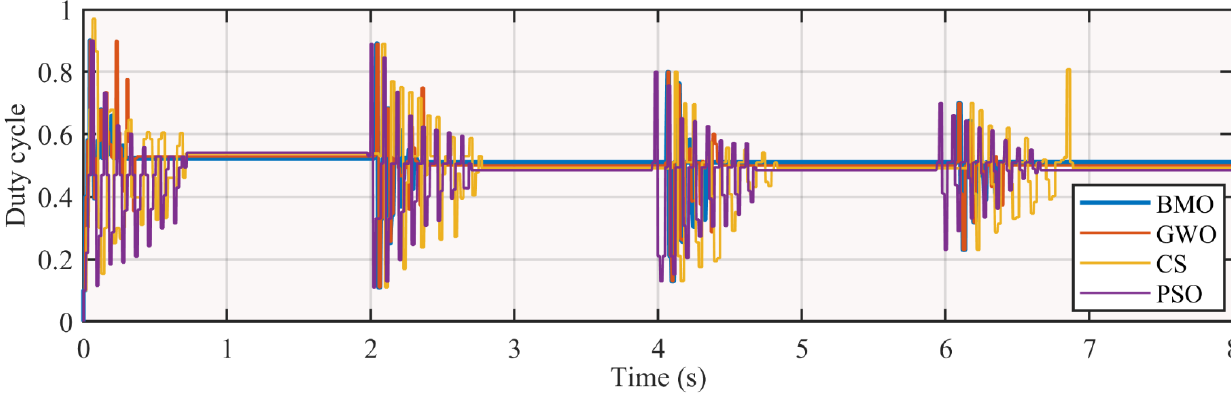
Figure 18. Competing techniques duty cycle Case-2.